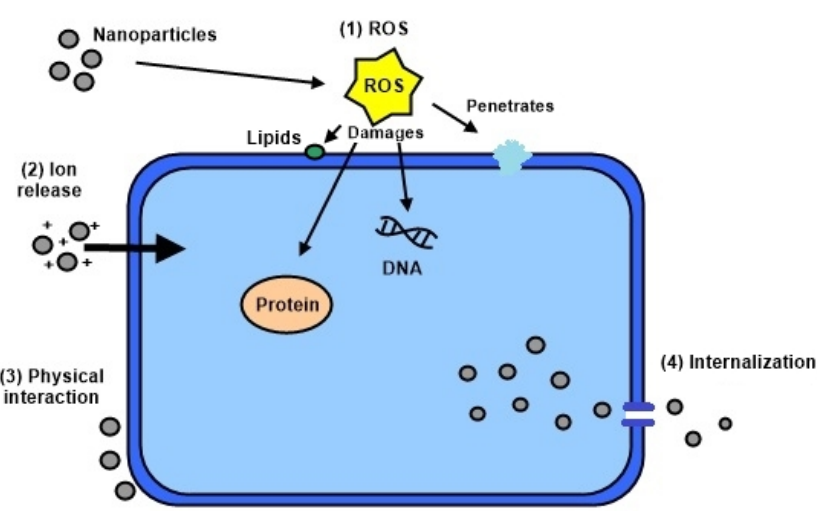
Figure 4. Various antimicrobial activities of metal nanoparticles. Reproduced with modification from Dizaj et al., Materials Science and Engineering : C; published by Elsevier, 2014. [72].